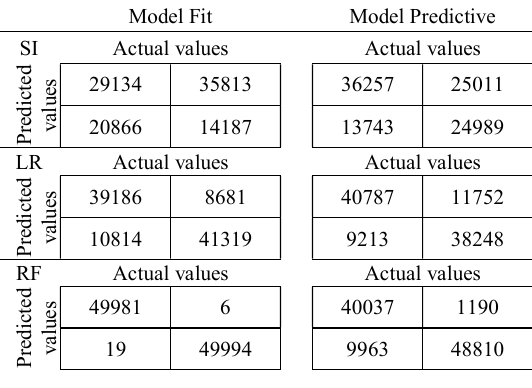
(Figure 7a, b) and in the overall model performance comparison in Figure